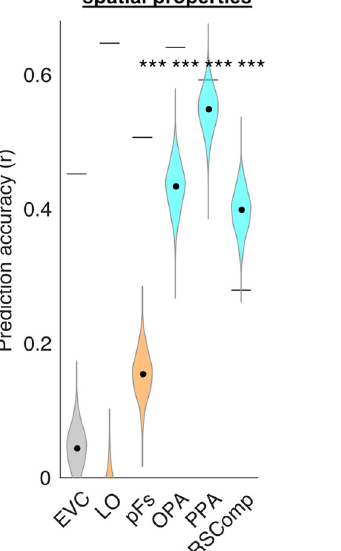
Fig. 8 Encoding model of object spatial properties predicts fMRI responses in functionally de fi ned ROIs. This plot shows the average prediction accuracies for encoding models in voxels from multiple regions of interest using object-wise spatial property ratings as regressors (i.e., real-world size and spatial stability). Object-selective ROIs are plotted in orange and scene-selective ROIs are plotted in cyan. The violin plots show the mean prediction accuracies (central black dots) and bootstrap standard deviations. The gray lines above each violin plot indicate the average voxel- wise split-half reliability of the fMRI responses in each ROI. As expected from previous results, object-wise spatial properties were good predictors of fMRI responses in scene regions. EVC early visual cortex, LO lateral occipital, pFs posterior fusiform, OPA occipital place area, PPA parahippocampal place area, RSComp retrosplenial complex. *** p < 0.001, uncorrected, one-sided permutation test. Exact p -values: EVC p -value = 1.4e − 01; LO p -value = 8.7e − 01; pFs p -value = 2.0e − 04; OPA p -value = 2.0e − 04; PPA p -value = 2.0e − 04; RSComp p -value = 2.0e − 04. Source data are provided as a Source Data fi le.